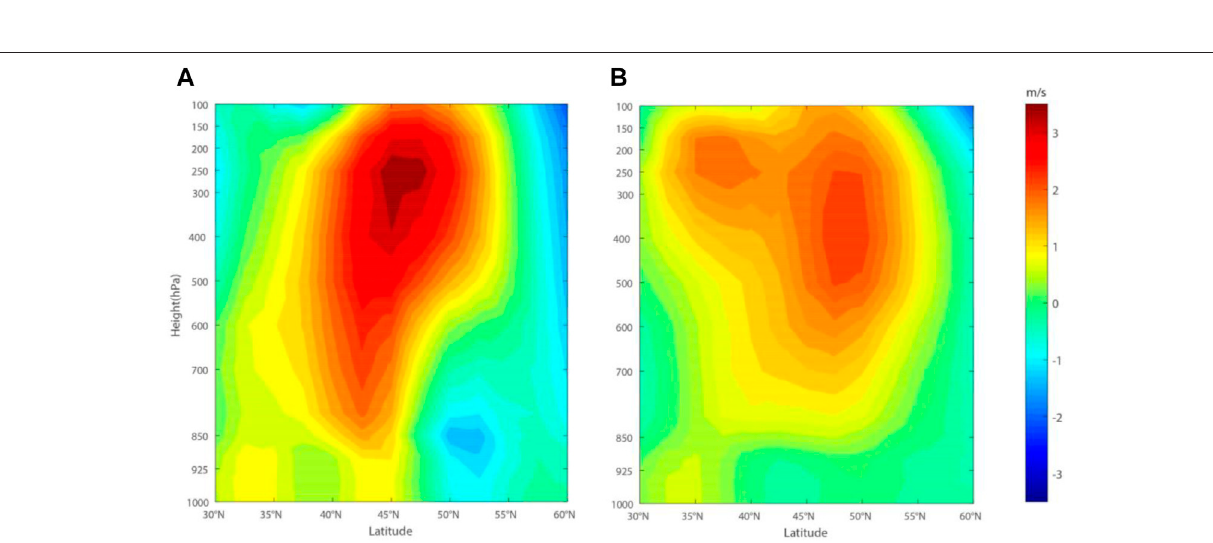
Frontiers in Environmental Science |